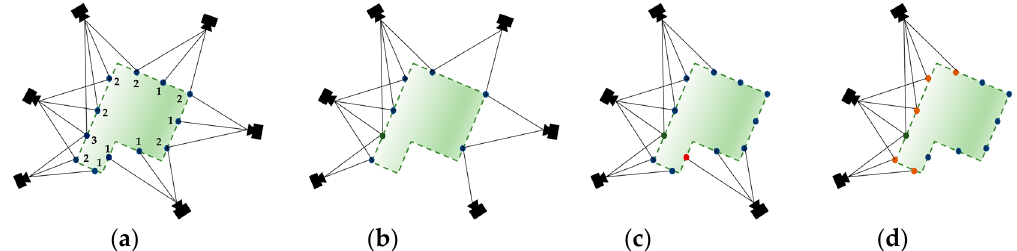
Figure 2. Visibility and co-visibility information. ( a ) Visibility graph. The original graph encodes camera and its corresponding visible points from the process of SfM pipeline. The blue points represent the 3D space, the black line represents the ray linking camera center and the points. The number indicates the number of cameras that observe the point. ( b ) The graph after applying the visibility filter with N = 1. ( c ) Co-visibility does not necessarily imply spatial continuity, i.e. the green point and red point are spatially close to each other but are not co-visible. ( d ) This figure shows the graph after applying the co-visibility filter for the green points. The orange points depict all the co-visible points (red points) of the green points; blue points are not co-visible.